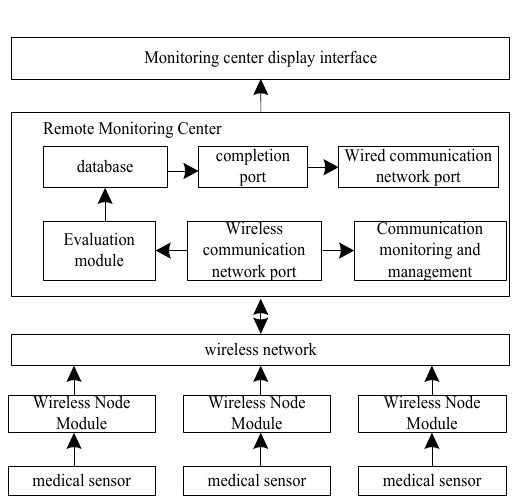
Figure 1. Telemedicine monitoring